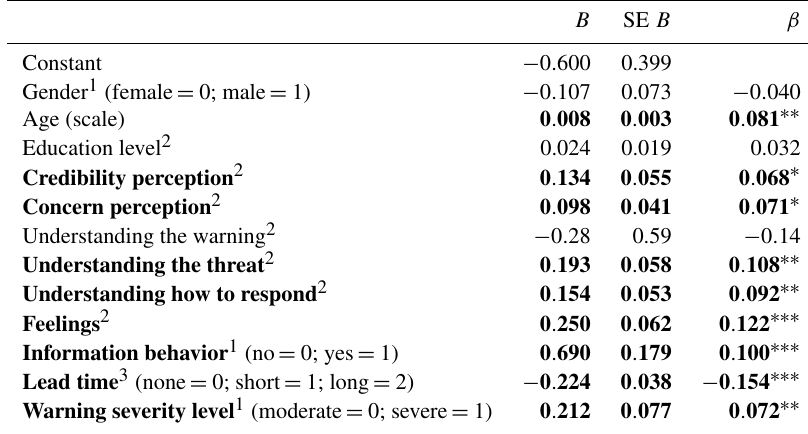
Table 4. Multiple linear regression with behavior as a dependent variable: R 2 = 0 . 36 ( p< 0 . 001), N = 1426.